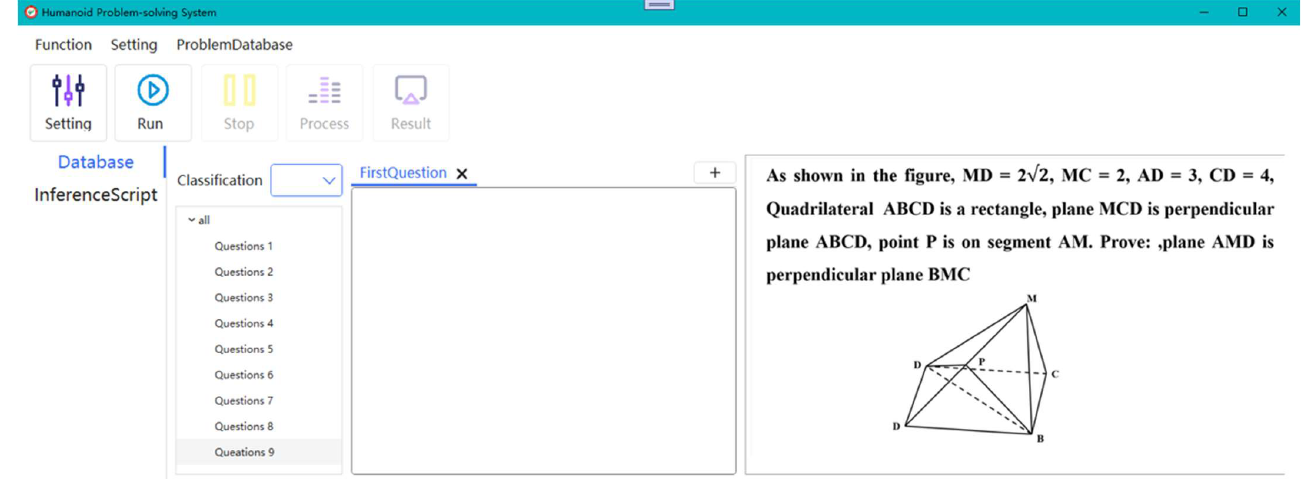
Figure 7. The operation interface of the automated geometry reasoning system.